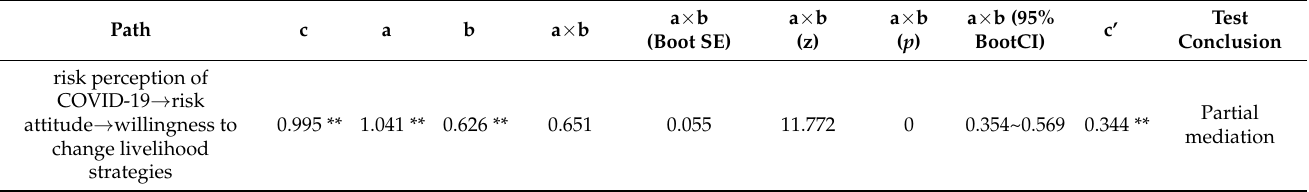
Table 6. Mediation effects test